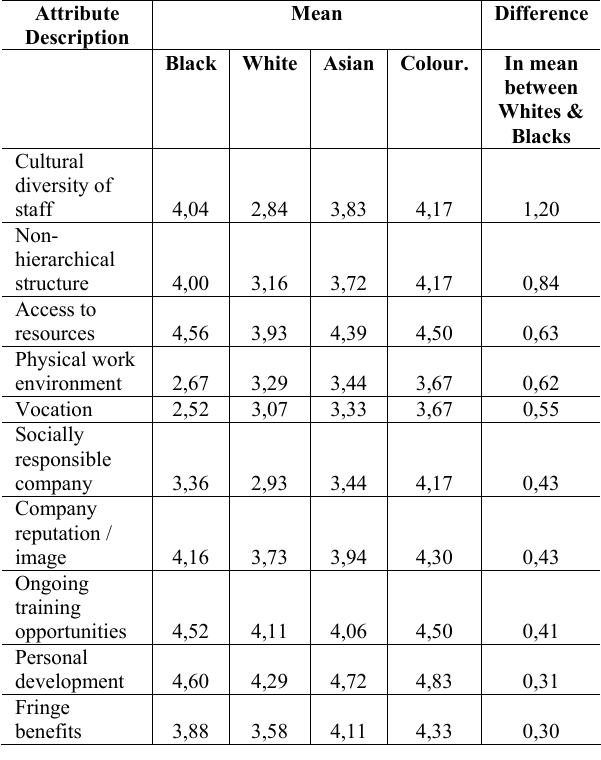
Table 9: The ranked significant differences between the four race